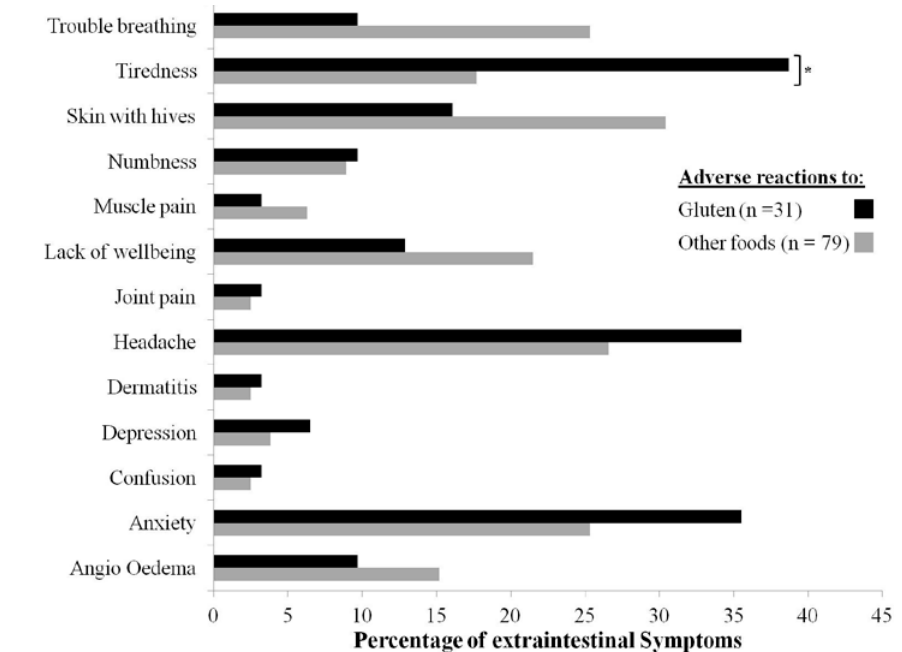
Figure 2. Recurrent self-reported extraintestinal symptoms. * p < 0.05.